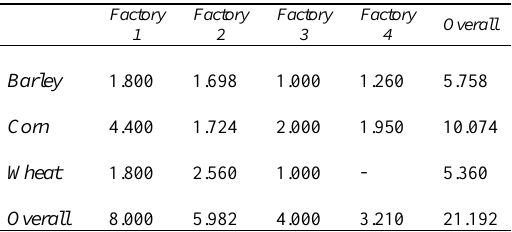
Table 8. Installed storage capacities (Units in Ton)